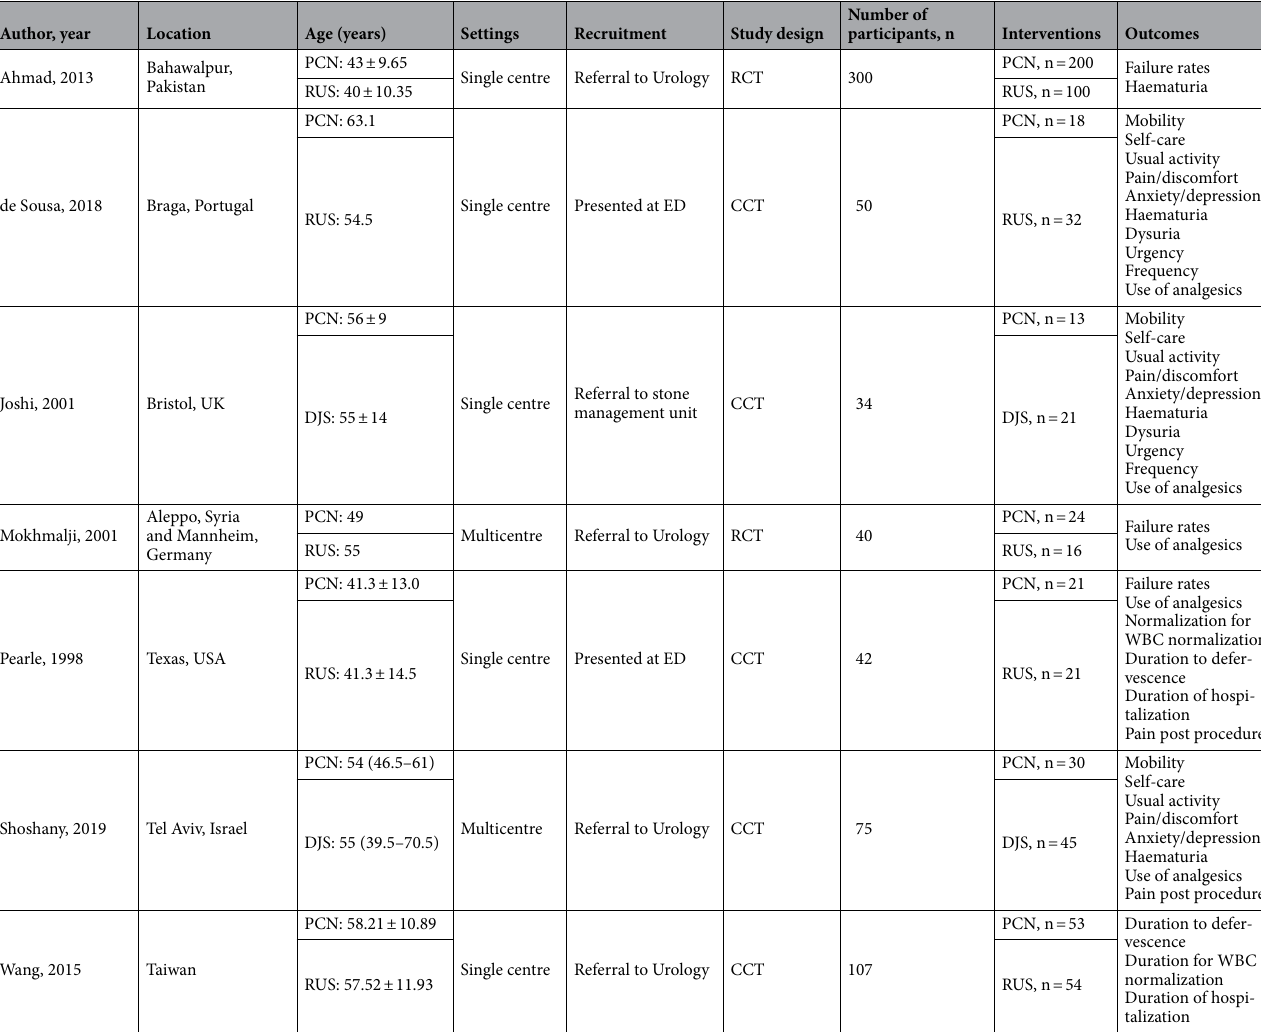
Table 1. Summary of included studies in meta-analysis.